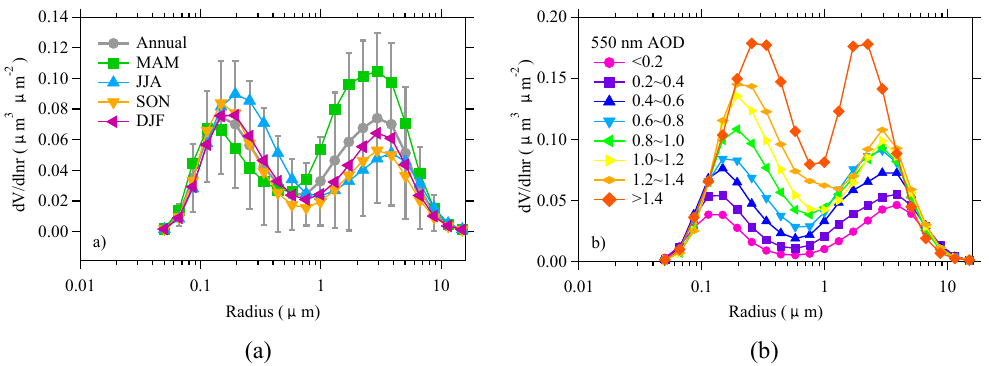
Figure 7. The averaged aerosol volume size (µm 3 µm − 2 ) distributions in different seasons (a) and in different AOD levels (b) in urban Nanjing.